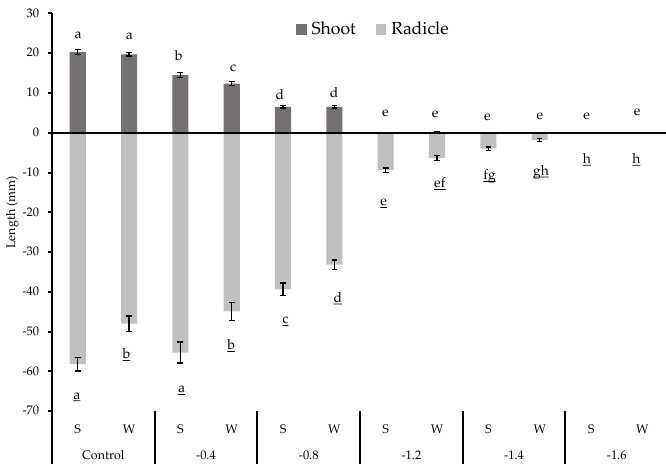
lowest (7.27 vs. 5.78 mm, spring vs. the winter types, respectively P ≤ 0.05).